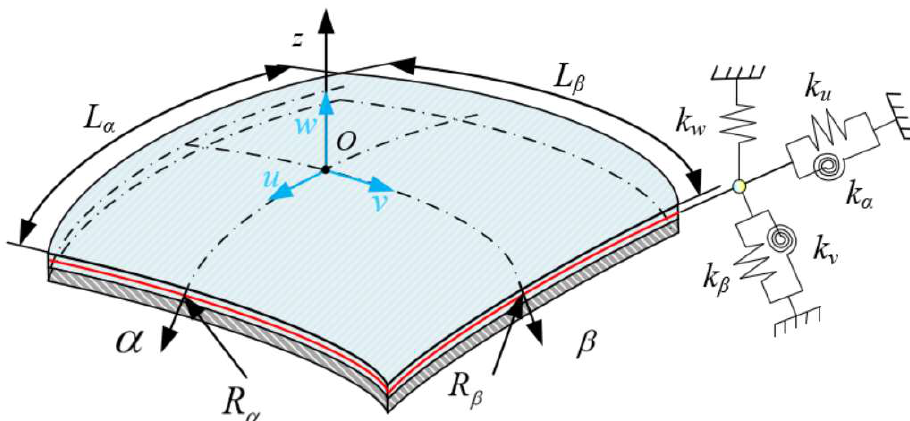
Figure 1. Diagram of shell element coordinates.